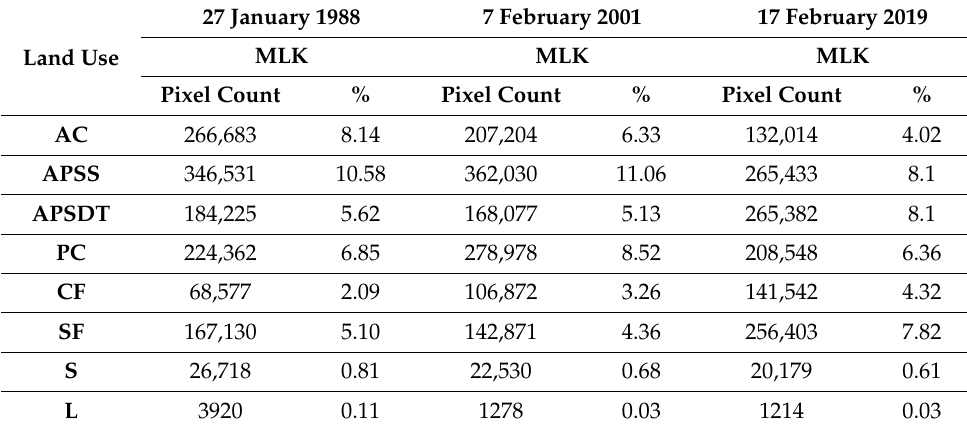
the last interval. Table 8. Pixels count and percent for each land use (according to